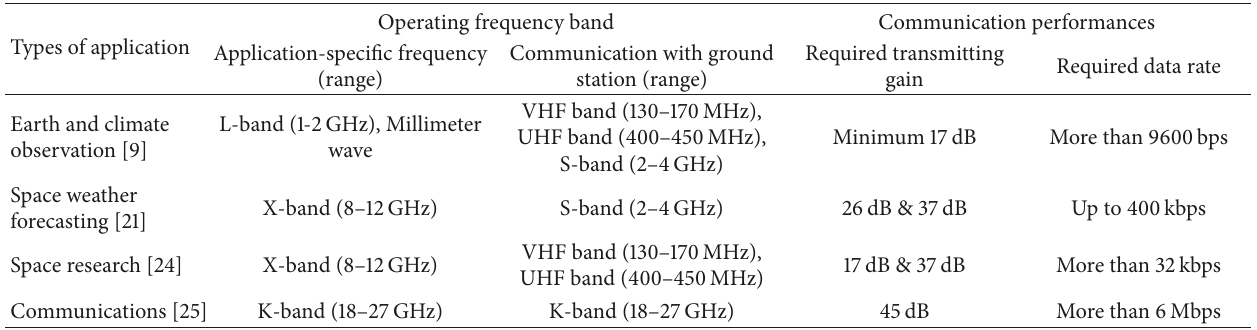
Table 1: Summary of the operating frequencies, data rate, and antenna gains for picosatellite